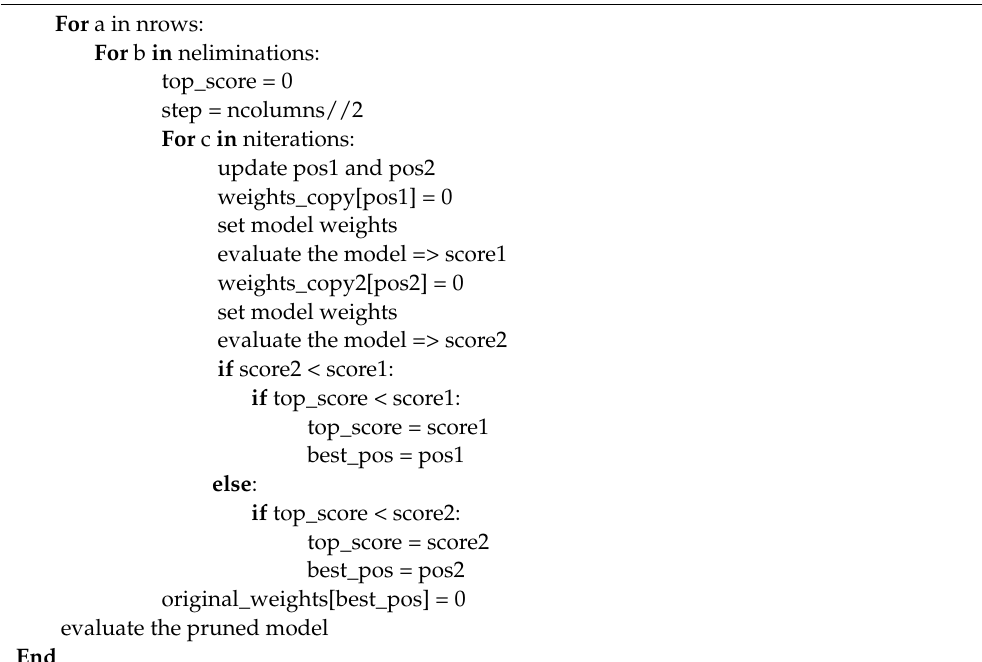
Algorithm 1. Pseudo-code of the Heuristic Partial Search